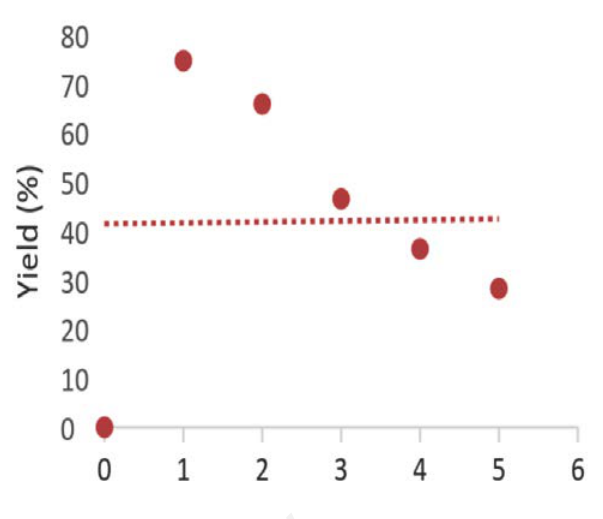
Figure 5. Relationship between glucose concentration (Cs) vs time. Figure 6. Graph relationship yield of CNCs vs reaction